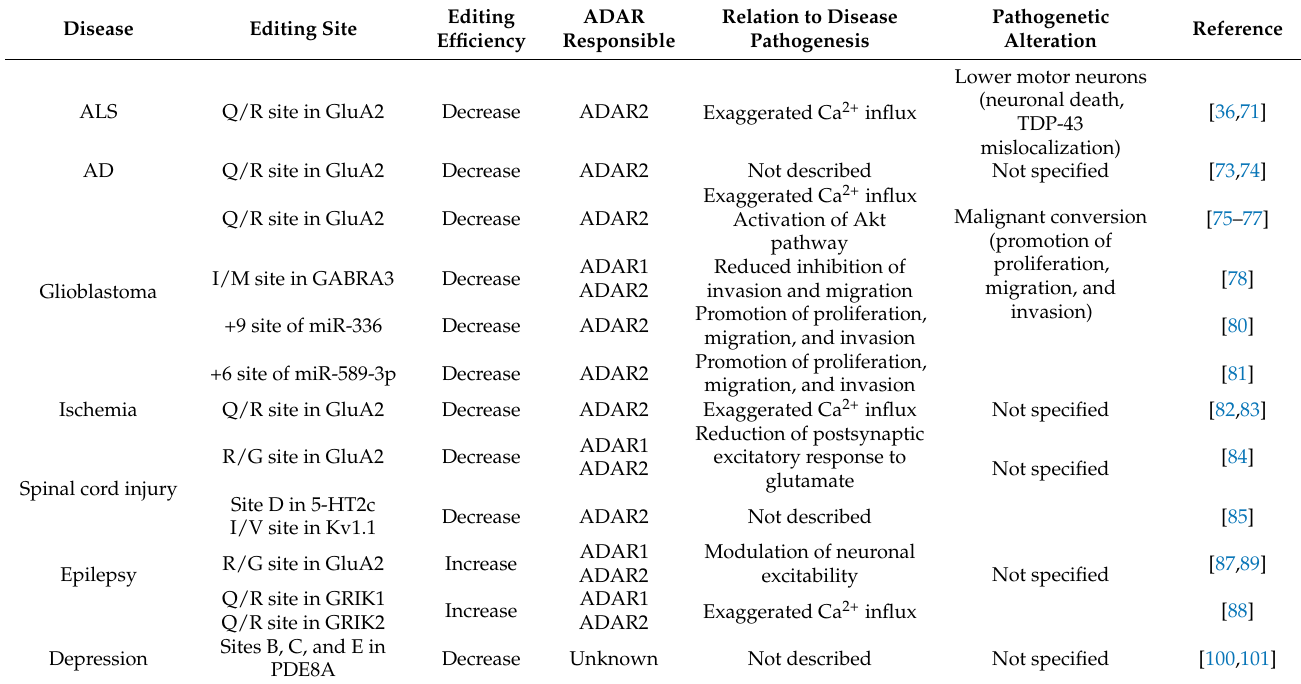
Table 1. CNS diseases linked to RNA